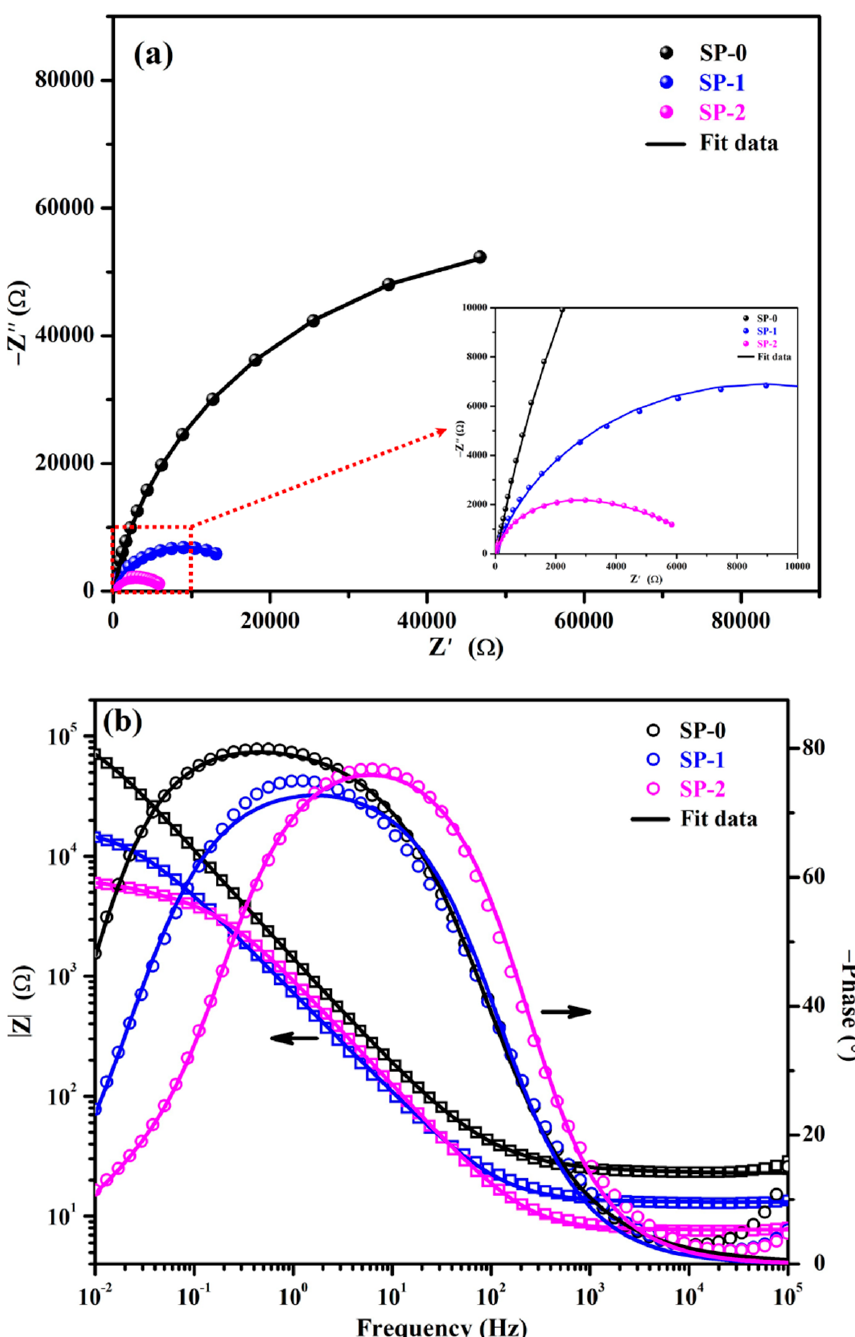
Figure 4. EIS plots for ( a ) Nyquist and ( b ) Bode spectra after 168 h of exposure. The Bode phase angles of steel rebars after 1 h of immersion are depicted in Figure 2b. It is observed that the steel rebar immersed in SP-0 solution exhibited two times more constants: one from 2 to 0.08 Hz at − 80 ◦ and another at lower frequencies, i.e., 0.01 Hz at − 56 ◦ , which is attributed to formation of strong passive films, i.e., Zwitterion–Fe complex. Alternatively, once 0.51 M NaCl was added in SP + 0.115M LA, i.e., SP1, the maxima shifted at a lower angle, i.e., − 70 ◦ compared to SP-0. However, broadening from the middle to low studied frequencies revealed that the passive film’s properties were retained. This means that 0.51 M NaCl is not enough to break the strong passive film. However, the steel rebar exposed to SP-2 solution exhibited shifting in terms of the phase angle maxima toward the middle frequency, and the asymmetric capacitive loop becomes sharp. The